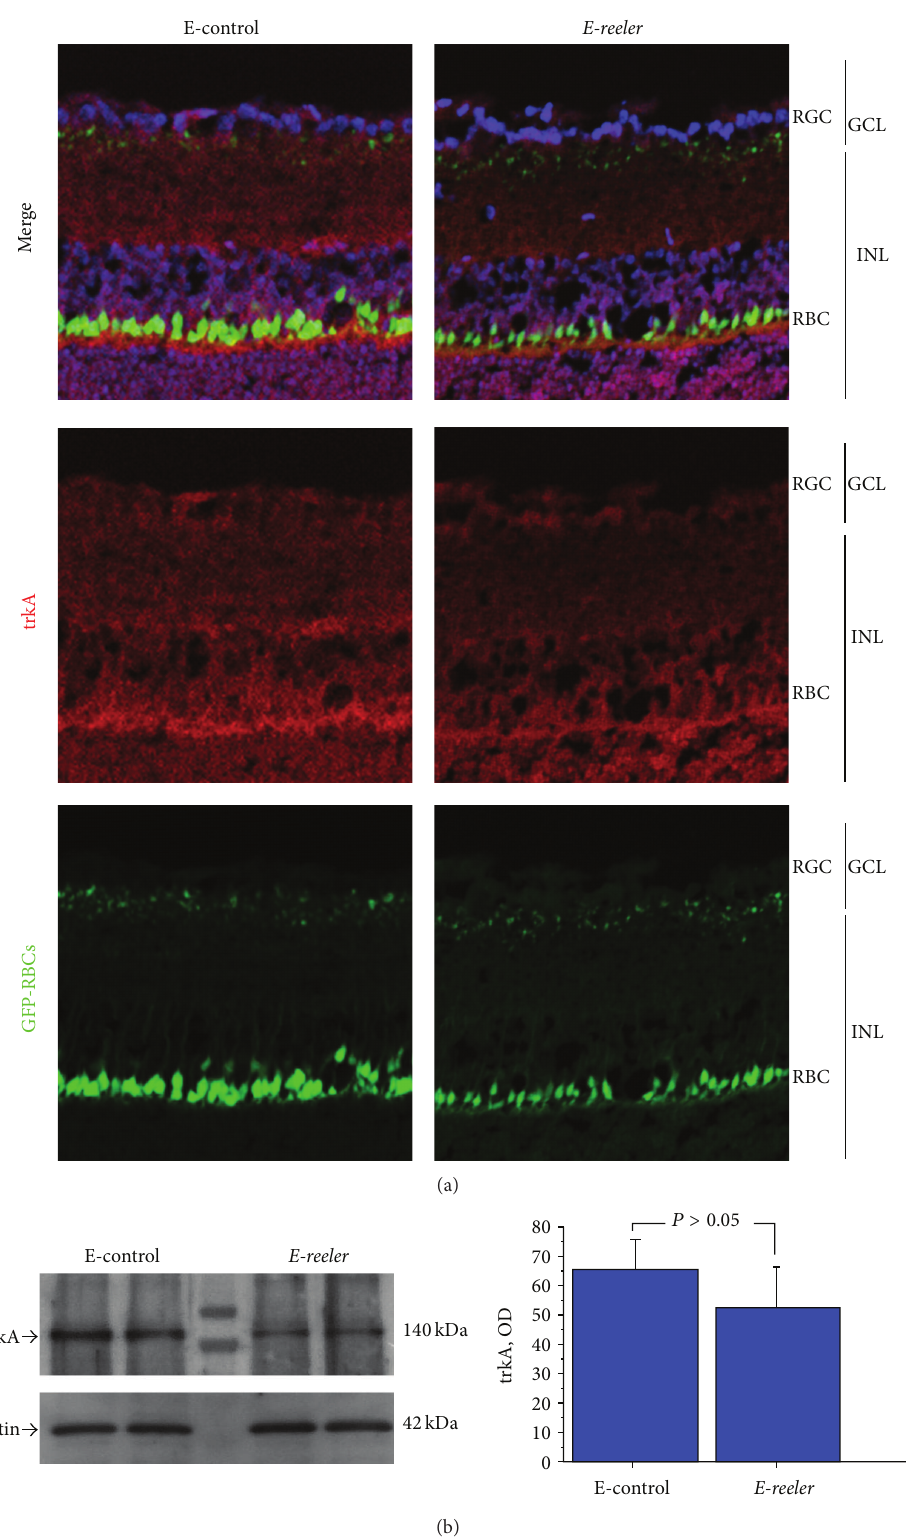
Figure 3: Expression of trkA NGFR in E-reeler retina. (a) Confocal microscopy showing images of GFP-expressing RBCs (green), trkA NGFR immunoreactivity (red), and nuclear staining (blue). A weak trkA NGFR immunoreactivity was observed at the RBCs (body and dendrites). trkA NGFR staining was less intense across the INL and in some cells inside the GCL of the E-reeler retina ( × 400). (b) Representative 7.5% SDS-PAGE and relative densitometric analysis of E-control and E-reeler retinal extracts probed with the trkA NGFR antibody (OD values; 𝑃 > 0.05 ). The size-marker was run between the two groups. Abbreviations: GFP, Green Fluorescent Protein; RGC, Retinal Ganglion Cells; GCL, Ganglion Cell Layer; INL, Inner Nuclear Layer; RBCs, Rod Bipolar Cells; OD, Optical